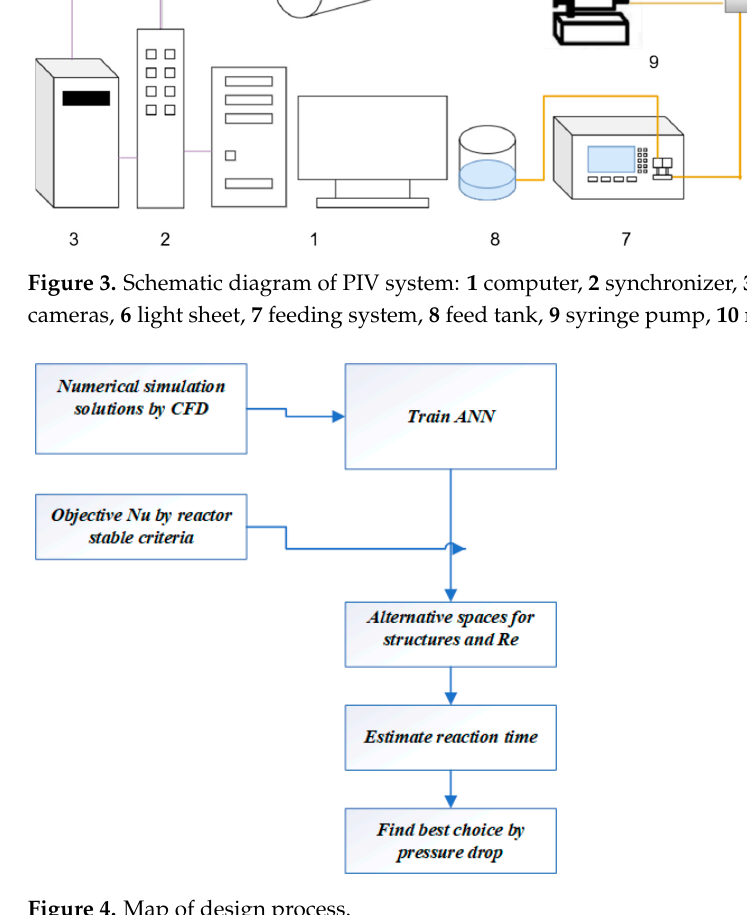
Figure 4. Map of design process.